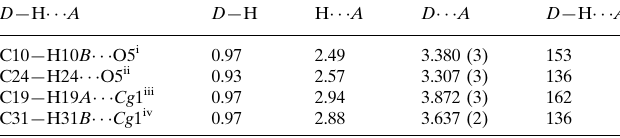
Hydrogen-bond geometry (A˚ , (cid:3) ). Cg 1 is the centroid of the C2–C7